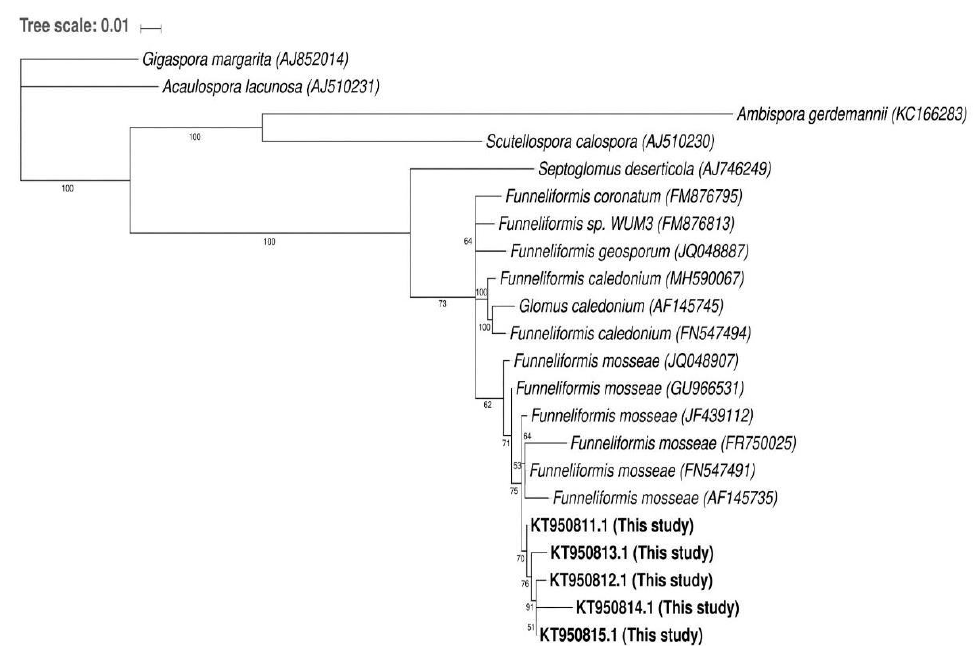
Figure 4. Phylogenetic tree constructed with a maximum parsimony analysis of taxa with the obtained SSCP sequences of closely related AMF species. References: the branches corresponding to partitions reproduced in less than 50% of bootstrap replicates are collapsed. The percentage of replicate trees in which the associated taxa clustered together in the bootstrap test (100 replicates) is shown next to the branches. Sequences generated in this study were registered in GenBank under the following accession number: KT950811, KT950812, KT950813, KT950814 and KT950815.